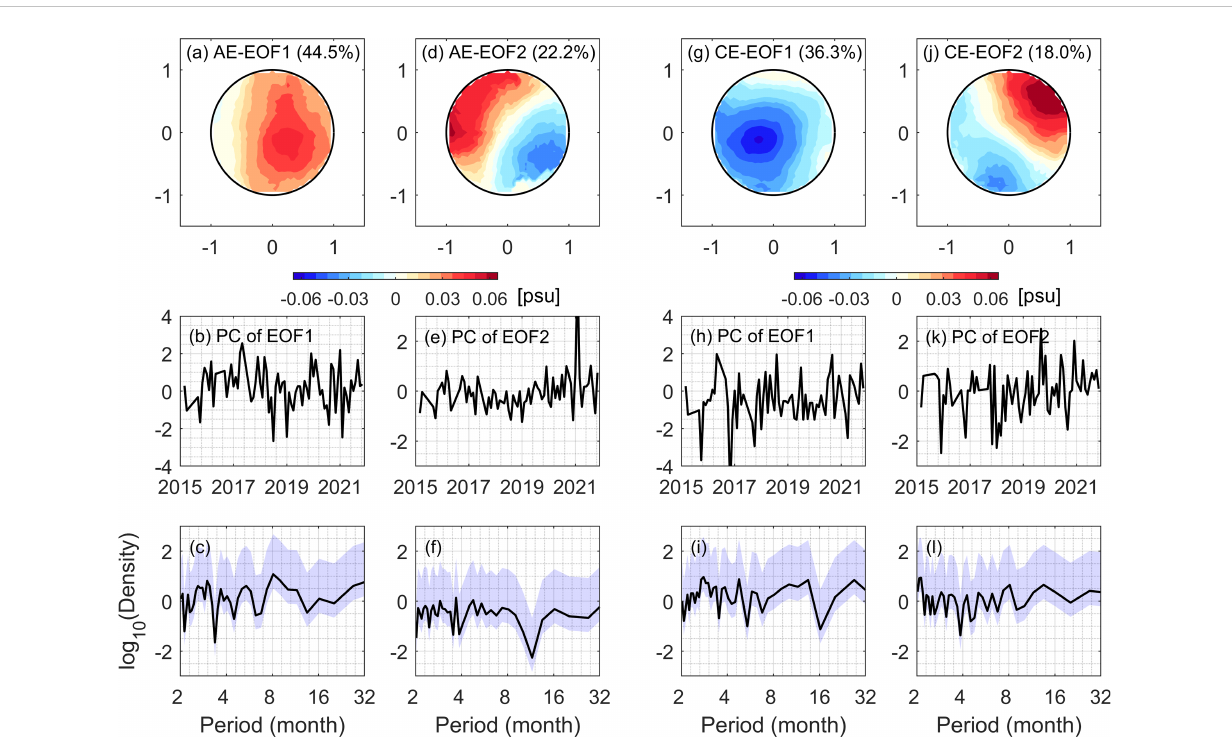
FIGURE 5 The (A) spatial pattern (unit: psu), (B) PC of EOF1, and (C) power spectrum of PC of the AE in the SCS. The shading indicates the salinity anomaly mode of the eddy composites and the purple area indicates the 95% con fi dence interval. Subgraphs (D – F) are for EOF2 of the AE in the SCS. Panels (G – L) are the same as (A – F) but for the fi rst two modes of EOF of the CE in the